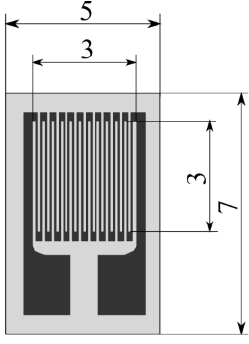
Fig. 3. Framework